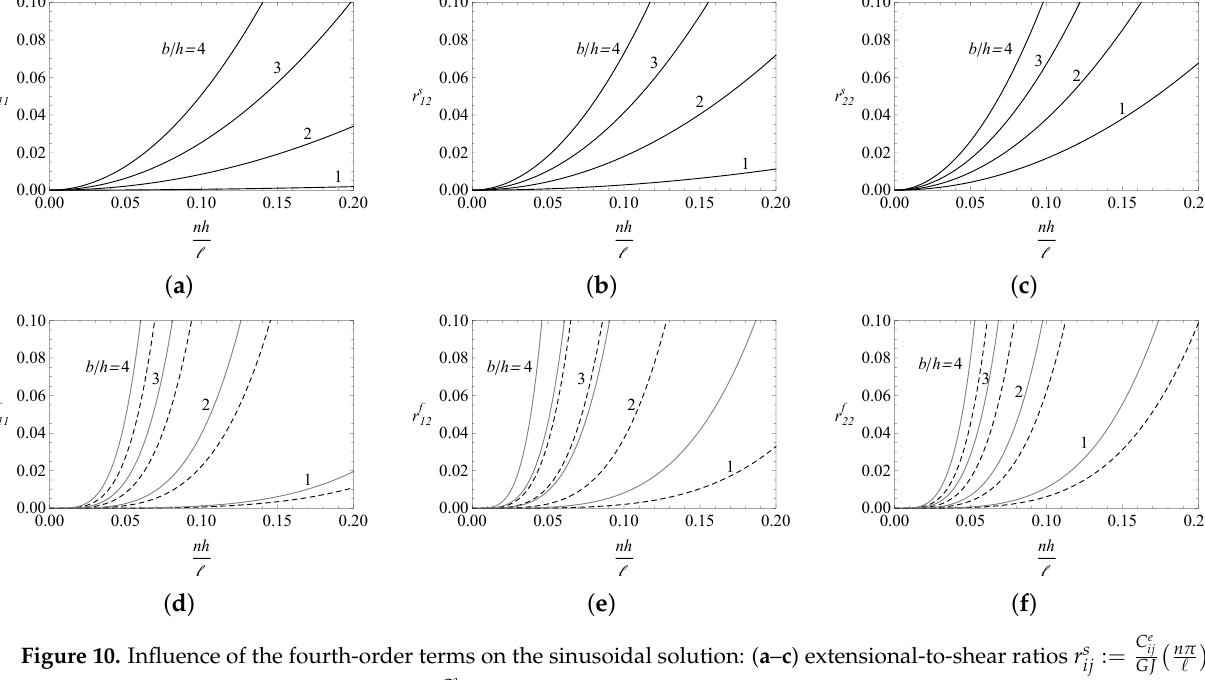
= 8 (gray continuous lines); t t 1